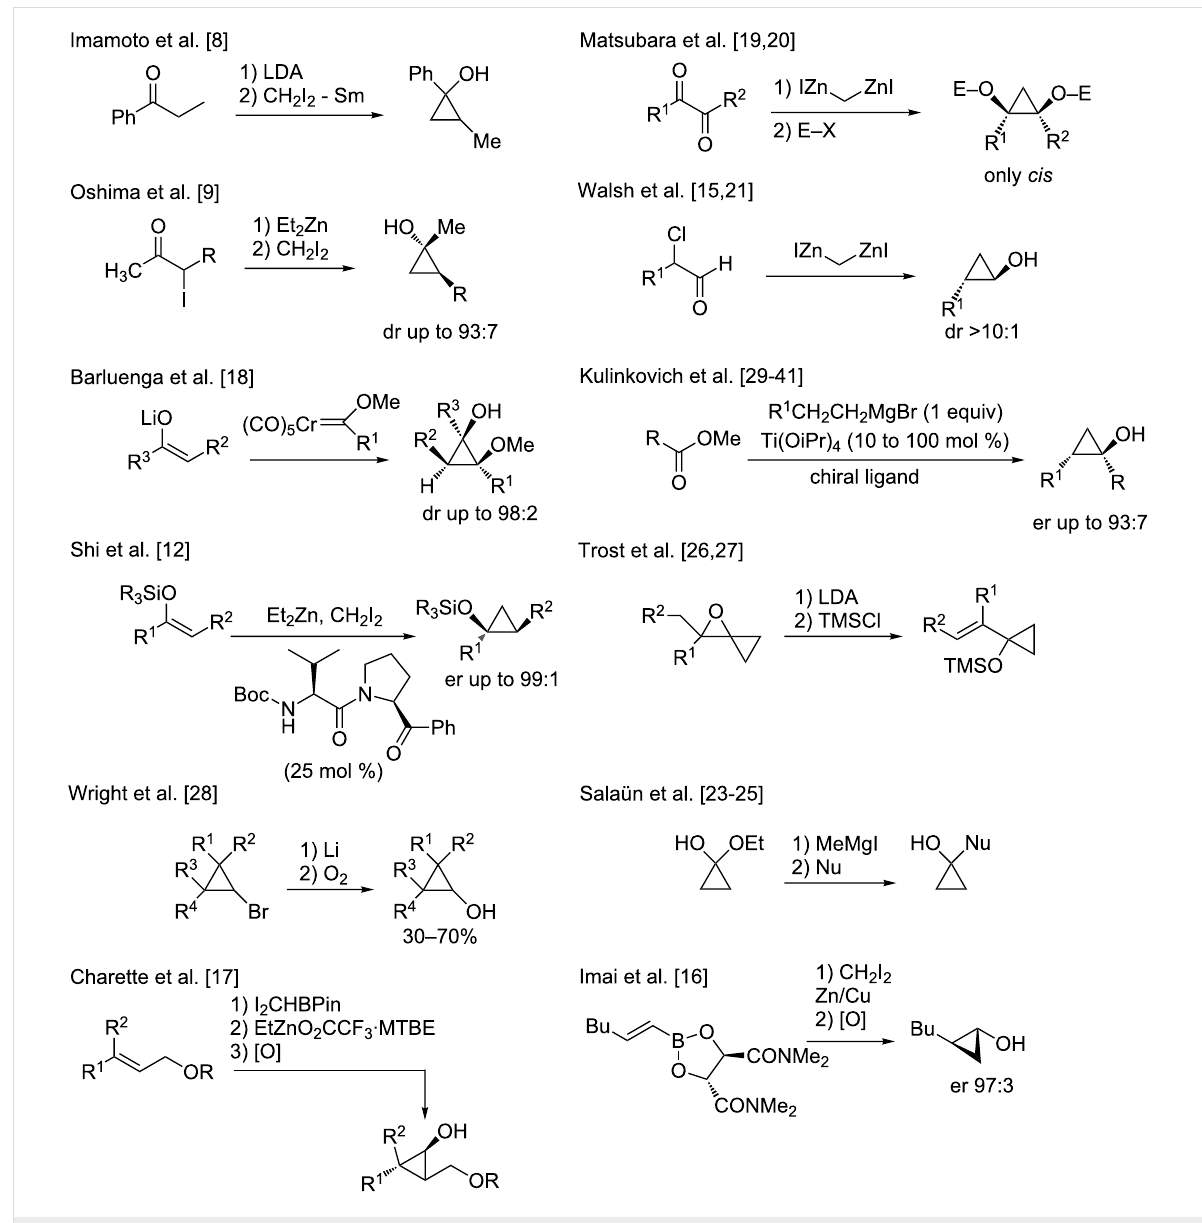
Scheme 1: Various strategies leading to the formation of